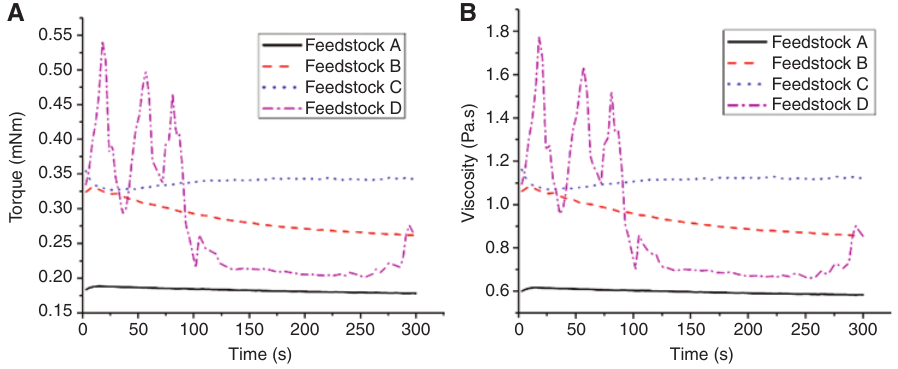
Figure 3 The estimation of feedstocks’s homogeneity. (A) Variation of feedstock’s torques and (B) variation of feedstock’s viscosity, respectively.